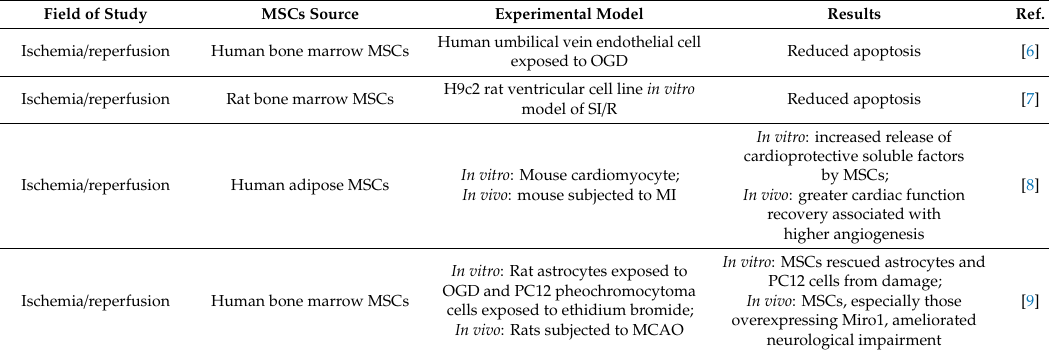
Table 1. Overview of the studies reported in this review regarding tunneling nanotubes (TNTs) tra ffi cking in preclinical models associated with mesenchymal stem cells (MSCs)